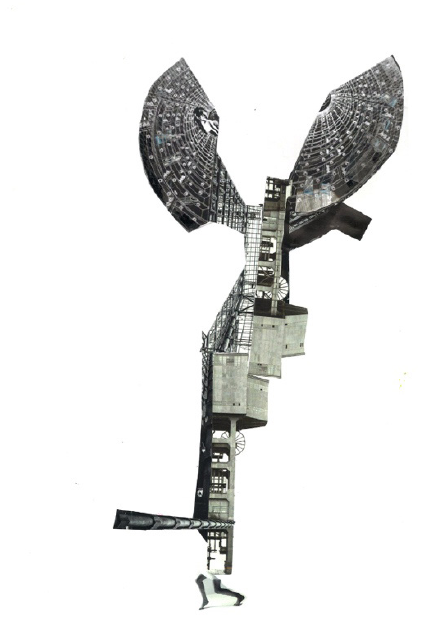
Figure 5. The Thousand Dreams of